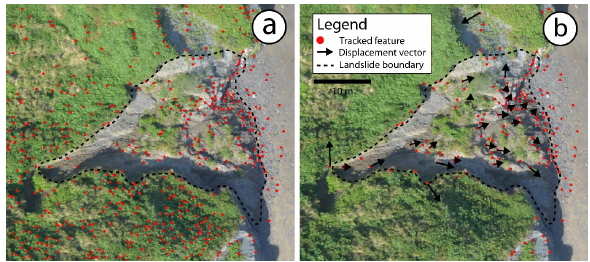
Figure 6: (a) Selected features in the study area for surface track- ing (b) Computed terrain